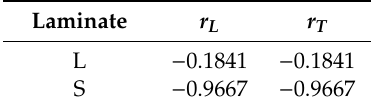
Table 6. r L and r T values for cross-ply (L) and sandwich